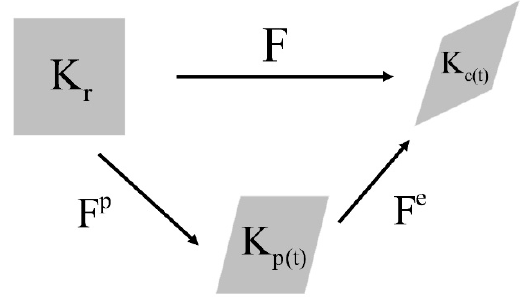
Figure 1. Multiplicative decomposition of the deformation gradient tensor.